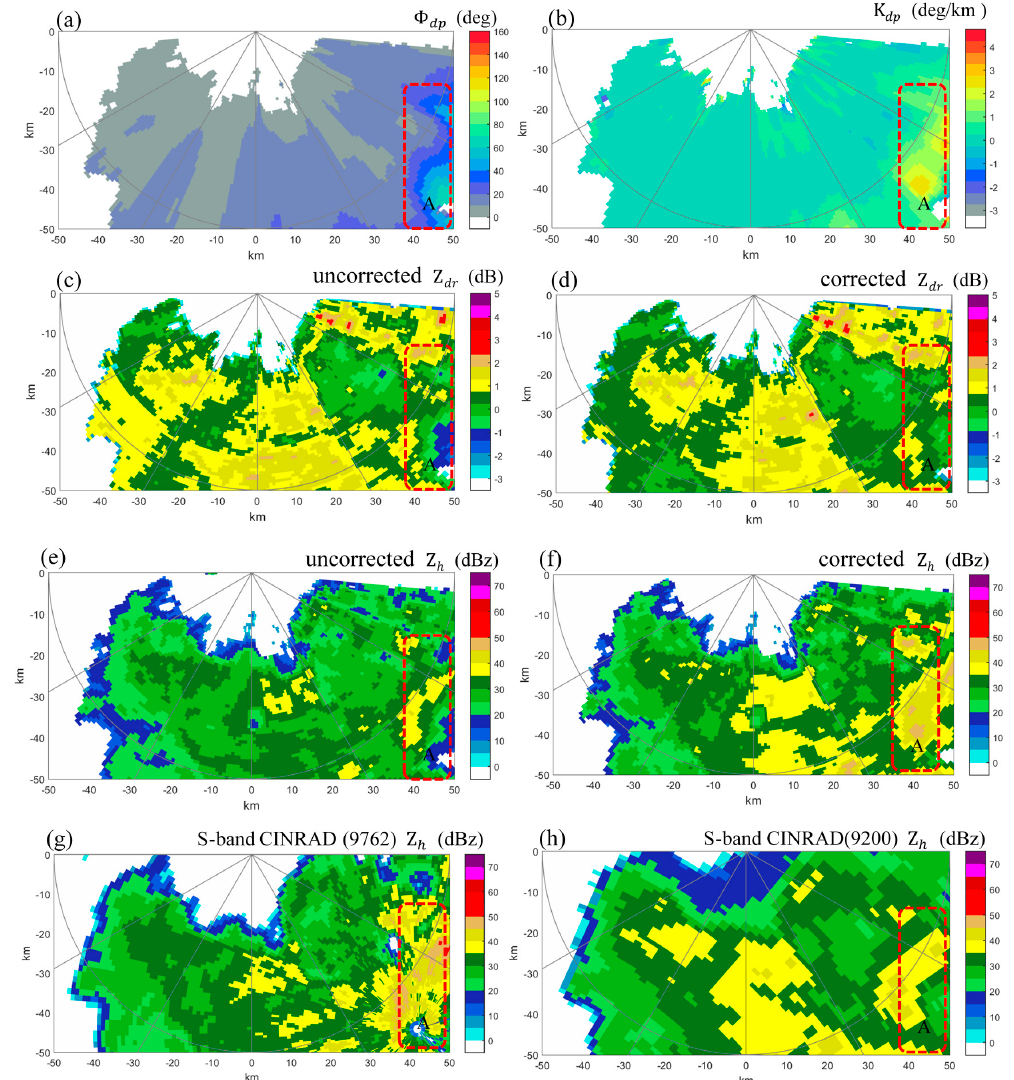
Figure 4 . PPI images of polarimetric variables observed at an elevation angle of 2.5°, at 11:57 (BJT) on 5 June 2016: ( a ) Φ (cid:3031)(cid:3043) ; ( b ) (cid:1837) (cid:3031)(cid:3043) ; ( c ) uncorrected (cid:1852) (cid:3031)(cid:3045) ; ( d ) corrected (cid:1852) (cid:3031)(cid:3045) ; ( e ) uncorrected (cid:1852) (cid:3035) ; ( f ) corrected (cid:1852) (cid:3035) ; 5 June 2016: ( a ) Φ dp ; ( b ) K dp ; ( c ) uncorrected Z dr ; ( d ) corrected Z dr ; ( e ) uncorrected Z h ; ( f ) corrected Z h ; ( g ) S-band CINRAD (9762) (cid:1852) (cid:3035) ; ( h ) S-band CINRAD (9200) (cid:1852) (cid:3035) . The red dashed rectangle A indicates the ( g ) S-band CINRAD (9762) Z h ; ( h ) S-band CINRAD (9200) Z h . The red dashed rectangle A indicates region with strong rainfall where the attenuation for the X-band happened heavily. the region with strong rainfall where the attenuation for the X-band happened